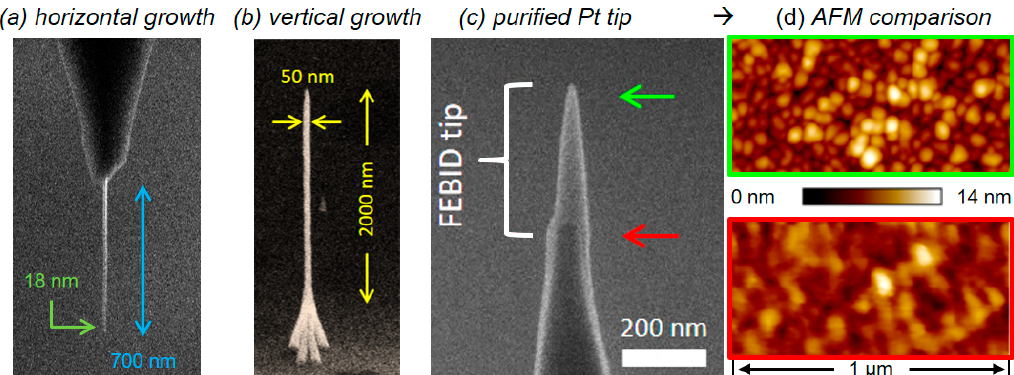
Figure 3. Feature sizes, 3D shape flexibility, and scanning probe microscopy (SPM) advantages: ( a ) shows a horizontally grown Pt–C FEBID tip, where the beam moves across the original tip edge (top-down in this image) with scan speeds around 30 nm/s. The resulting nanowires reveal constant widths in the sub-20 nm regime along the entire tip; ( b ) vertically grown 3D tip, composed of a four-legged base, which then converges to a tall single pillar. While the latter enables high aspect ratio measurements, the former increases the mechanical stability and the adhesion to the surface; ( c ) shows a FEBID modification (green arrow) of a Pt–Ir coated conductive-atomic force microscopy (C-AFM) tip (red arrow). The tip was also fully purified, revealing a tip radius below 10 nm, which strongly improves the lateral resolution capabilities, as shown in ( d ) by a direct comparison of FEBID (top) and the original Pt–Ir tip (bottom), performed on a nanogranular gold sample. The scan width is 1 µm, while both Z scales span across 14 nm, as indicated.